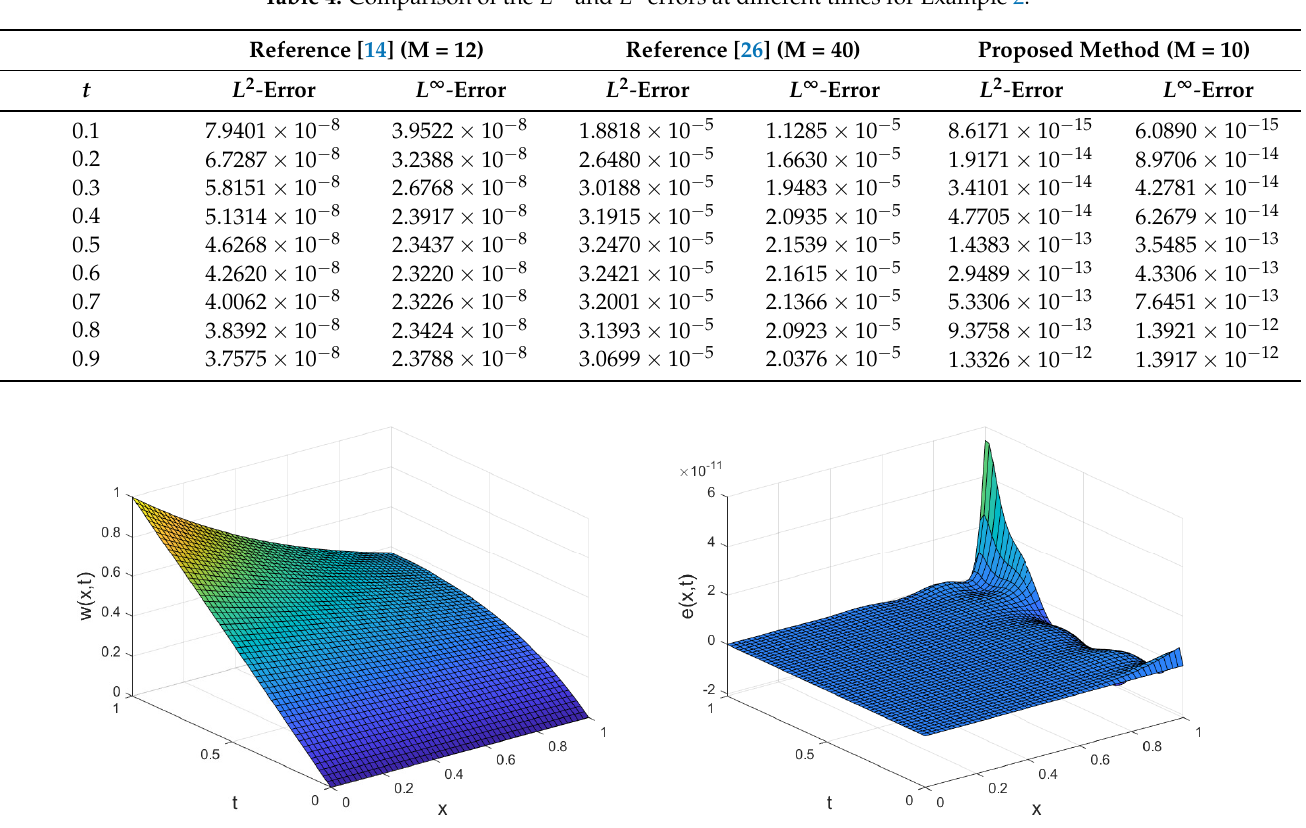
Table 4. Comparison of the L ∞ and L 2 errors at different times for Example 2.